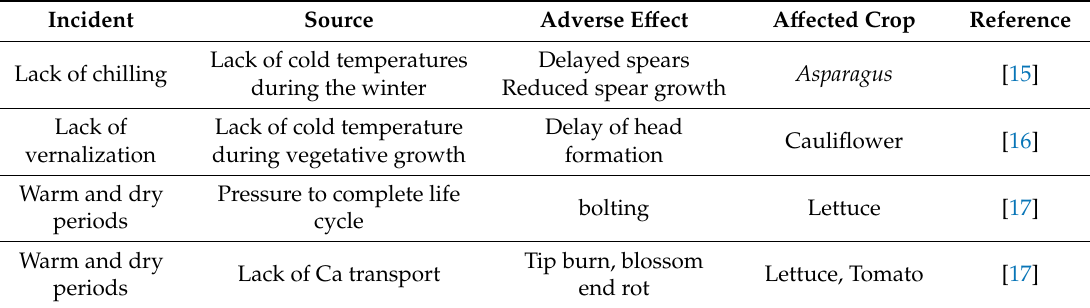
Table 1. Examples of adverse climate change e ff ects on vegetables.